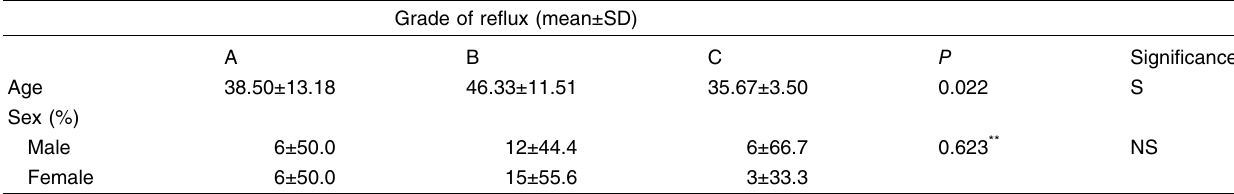
Table 3 Comparison between cases with different grades of reflux as regards personal data